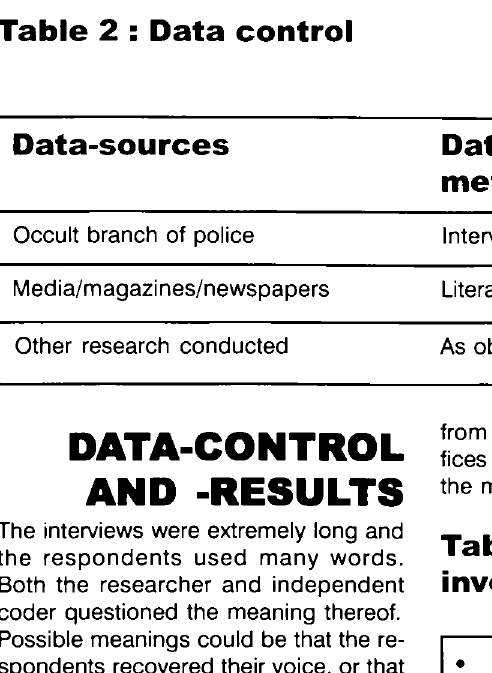
Table 2 : Data control